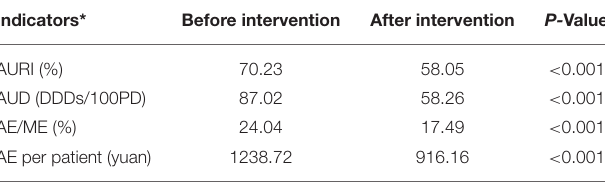
TABLE 3 | Overall changes of four indicators representing inpatient antibiotic use.